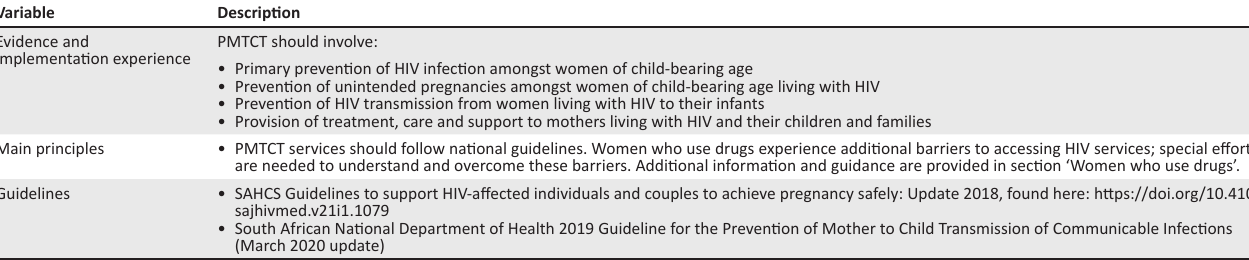
TABLE 20: HIV testing treatment and care – prevention of mother-to-child transmission of HIV. 19